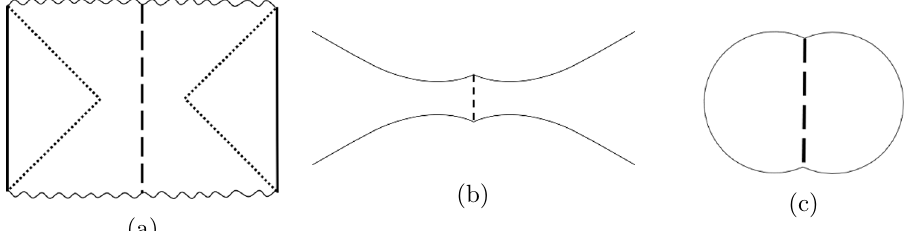
Figure 21 . Adding a positive tension brane to the center of the Einstein-Rosen bridge separates the left and right horizons, creating a Python’s Lunch. The Lorentzian geometry of such a state in shown in (a). A Cauchy slice is shown in (b). Such a state can be easily constructed using a Euclidean path integral with a heavy operator insertion halfway between the left and right boundaries, as shown in (c). However it cannot be easily constructed using unitary evolution from the thermo(cid:12)eld-double state.